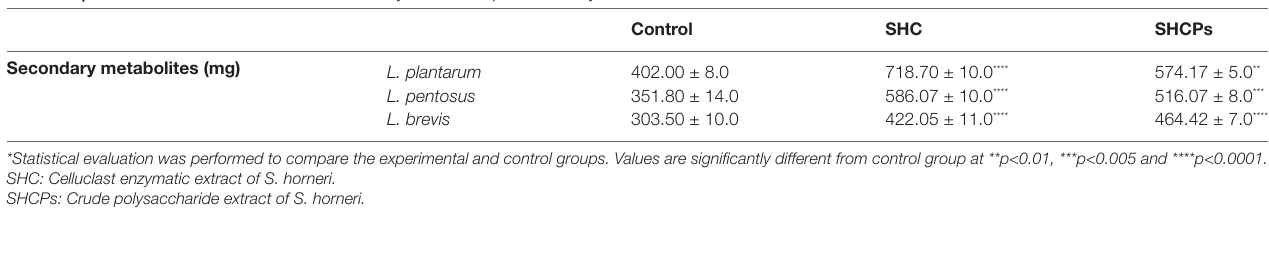
TABLE 1 | Effects of SHC and SHCPS on secondary metabolite production by